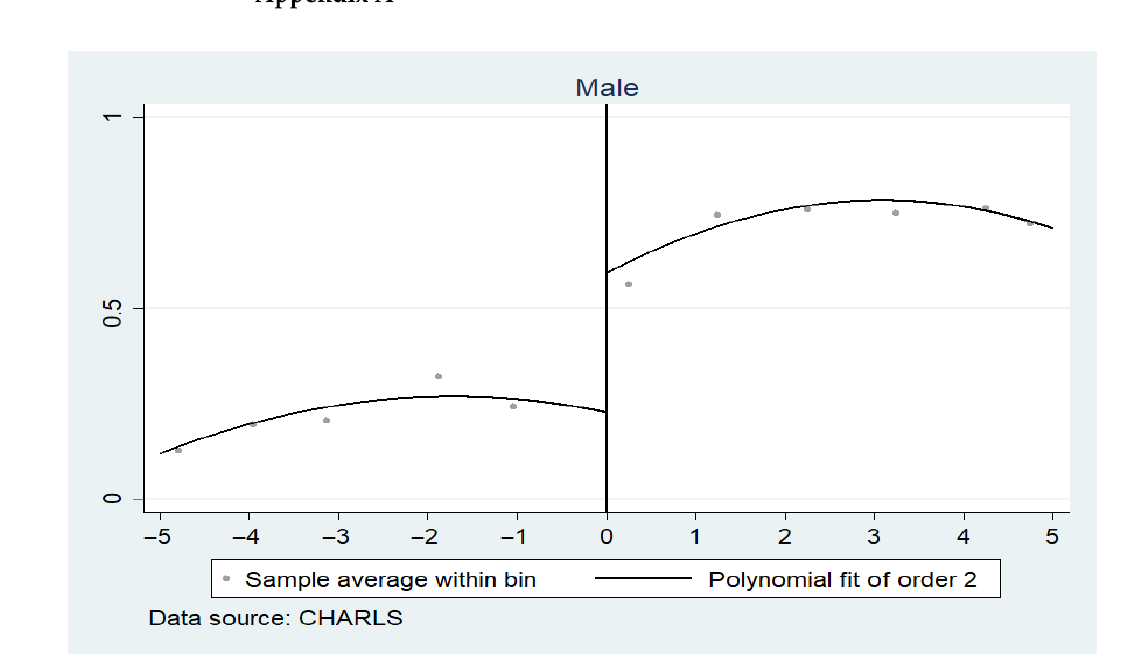
Figure A1. Discontinuity diagram of the average retirement rate of men by age.